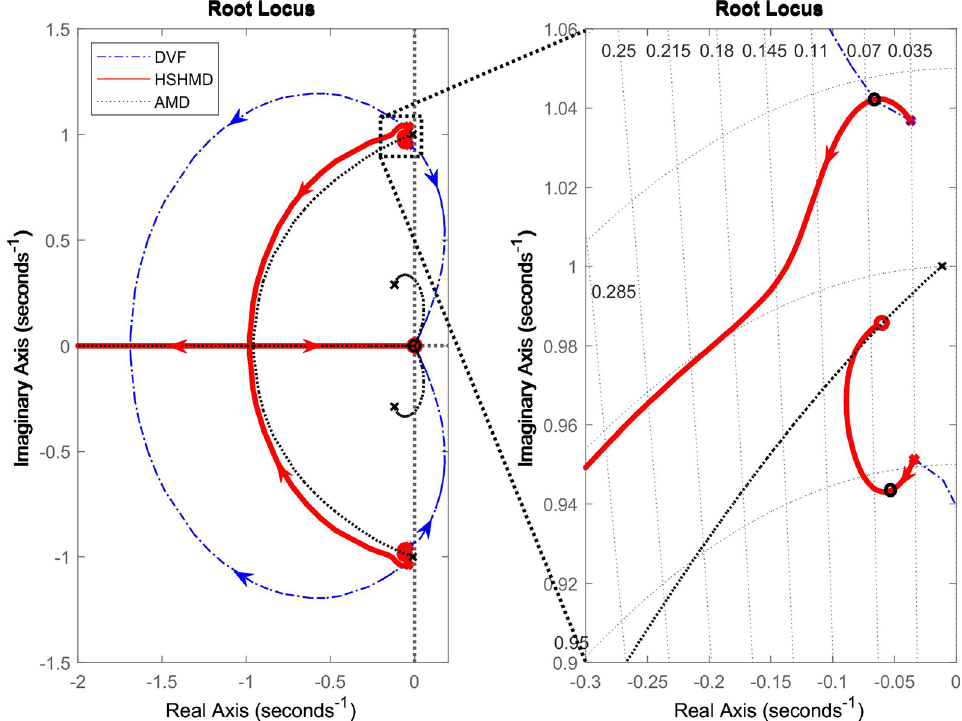
Fig. 3. Root locus of hybrid devices. Blue: Direct Velocity Feedback. Red: Hybrid SkyHook Mass Damper. Black: Active Mass